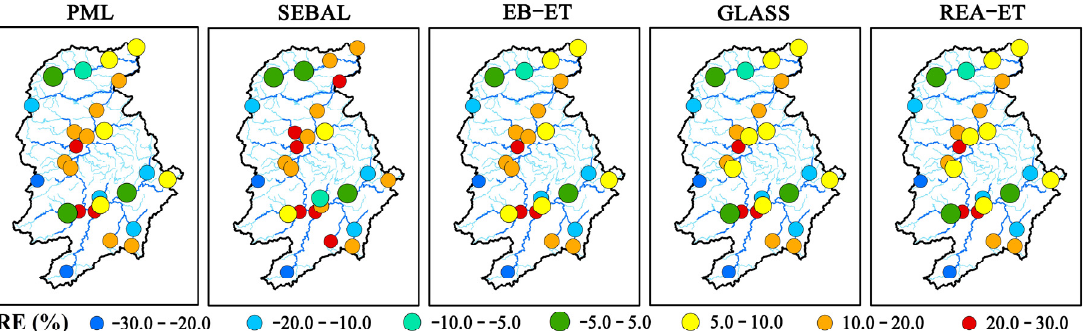
Figure 9. The RE of each sub-basin between the observed multi-year (2005–2010) streamflow and